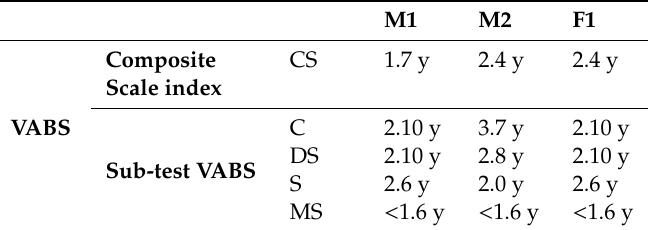
Table 2. Participants’ adaptive